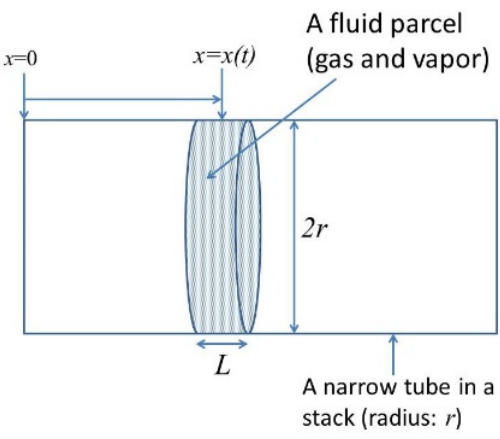
Figure 14. A fluid (a mixture of gas and water vapor) parcel in a narrow tube in a stack of a thermoacoustic engine. Reprinted with permission from Ref. [90]. Copyright 2017, the Acoustical Society of America.